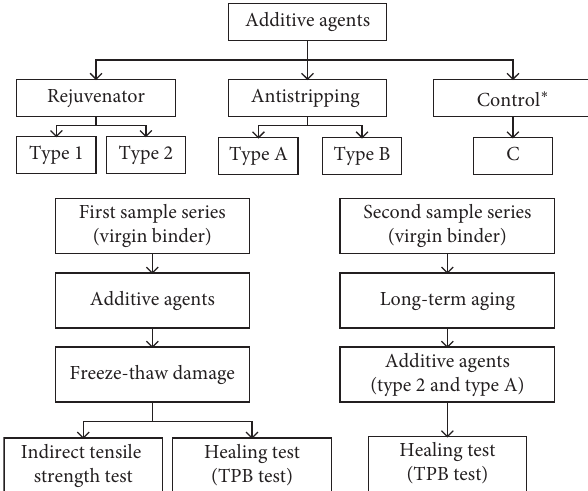
Figure 1: Research flowchart. ∗ Mixture without additive